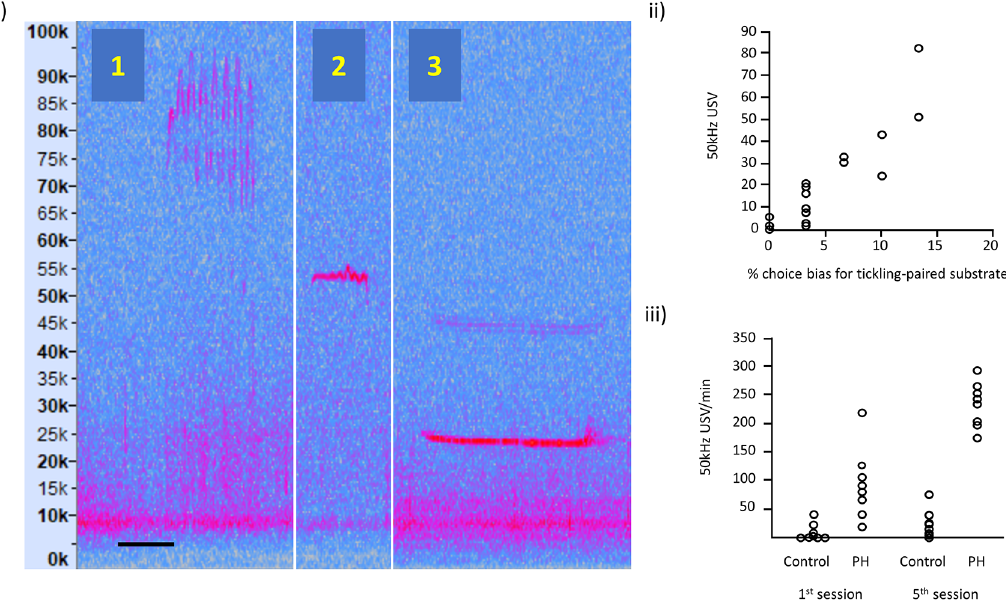
Figure 2. Examples of rat ultrasonic vocalisations (USVs). (i) Illustration of: (1) frequency modulated 50 kHz USVs, (2) flat 50 kHz USV and (3) 22 kHz USV; the spectrograms are taken from our own recordings and these vocalisations are typically expressed in all rats. Vertical axis represents USV frequency (in kHz) and horizontal scale bar represents 50 ms for USV 1 and 2, and 200 ms for USV 3. (ii) Relationship between 50 kHz USV production and an affective bias test (redrawn with data available online, and reproduced with permission from Hinchcliffe et al. , 2020). Each data point represents, for each of the 16 rats, the 50 kHz USV response to tickling and the substrate preference in the Affective Bias Test, indicative ofthe degree of emotional valence. (iii) USVsin playfully handled (PH)rats compared to a control group on the 1 st and 5 th session of treatment (redrawn with data available online and reproduced with permissionfromBombail etal. ,2019).Bythe5 th session,allPHratsshowedanincreaseinUSVproductionincontrast to panel (ii), which used the standard protocol where some rats show little or no increase in